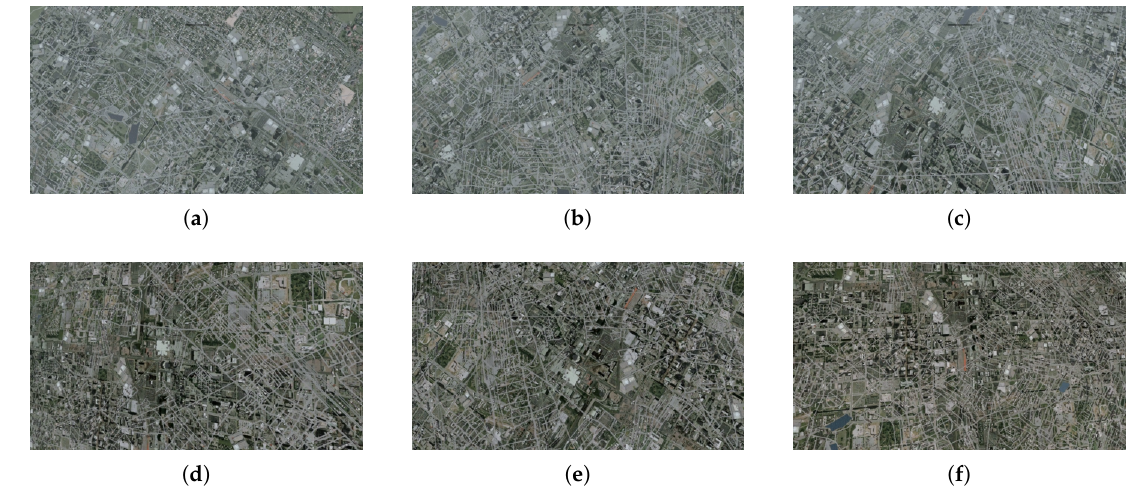
Figure 12. Selected frames from test videos in group 4: ( a ) 0.3 NM, ( b ) 0.4 NM, ( c ) 0.5 NM, ( d ) 3–5 NM, ( e ) 5–10 NM, ( f ) >10 NM.